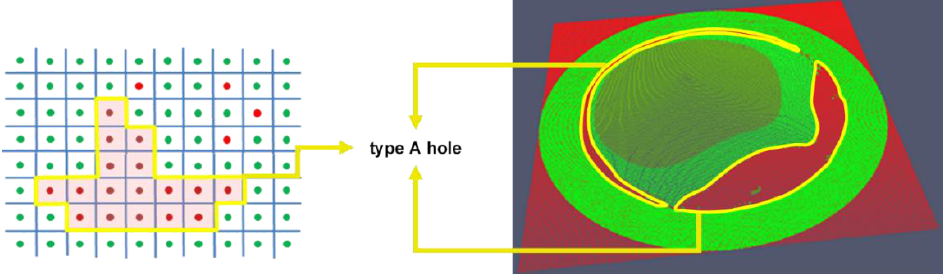
Figure 22. Type-A hole. Illustration on Patient002.